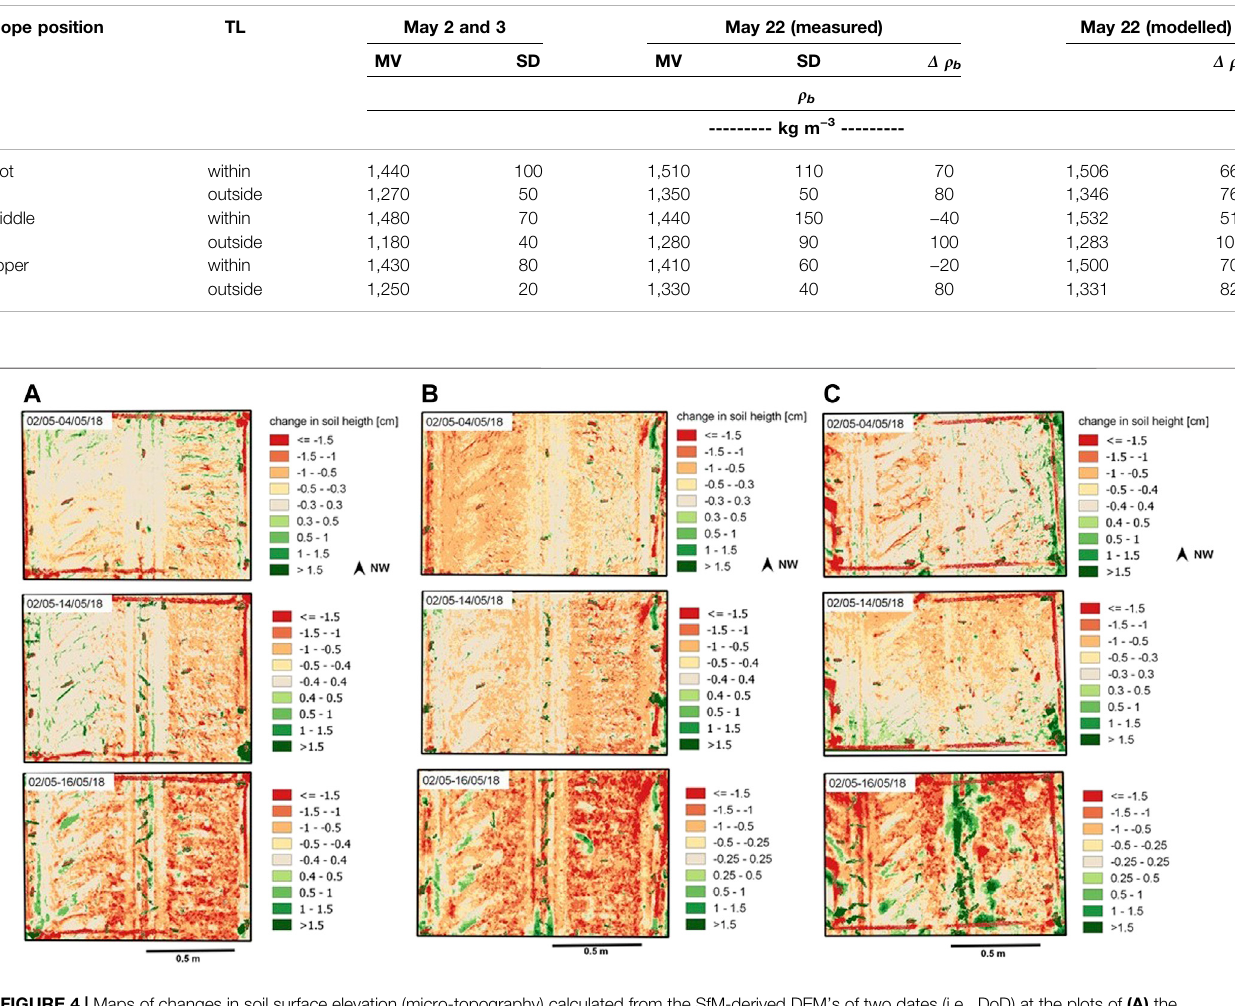
Frontiers in Environmental Science |